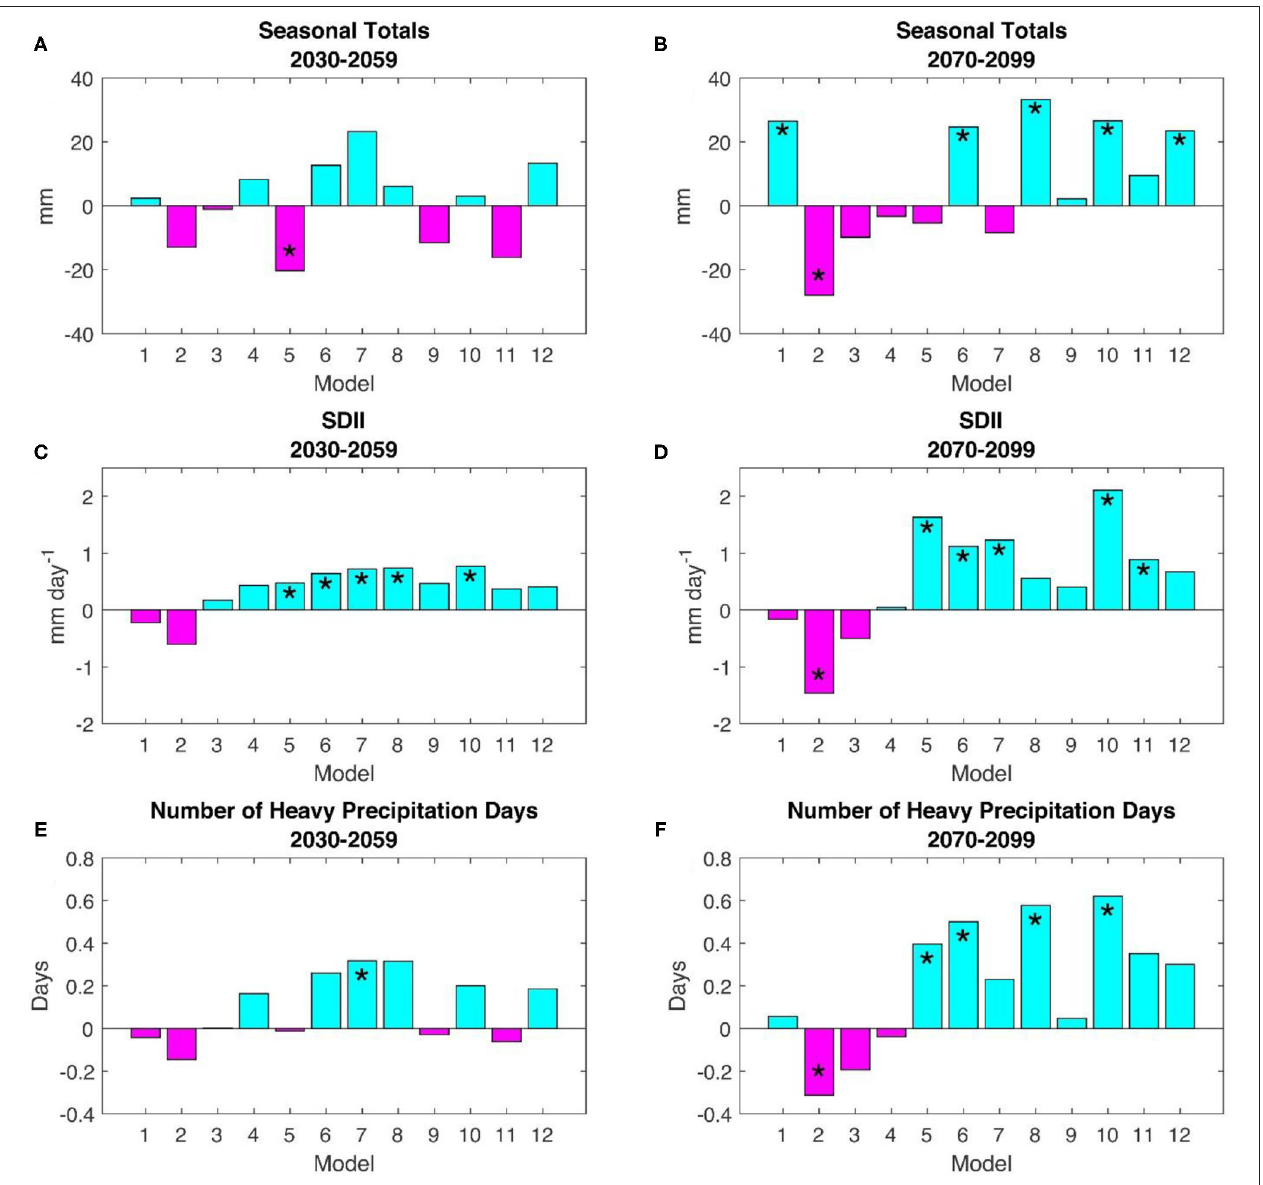
FIGURE 7 | The projected changes in the 30-year, regionally averaged summer climatologies for each NA-CORDEX model in mid- (2030–2059) and late-century (2070–2099), relative to the model historical period (1976–2005). Shown are the seasonal precipitation totals [ (A,B) , mm], SDII [ (C,D) , mm day − 1 ], and the number of heavy precipitation days [ (E,F) , days]. Model numbers are the same as in Table 1 . Asterisks indicate models where the regional change was statistically significant at the 5%